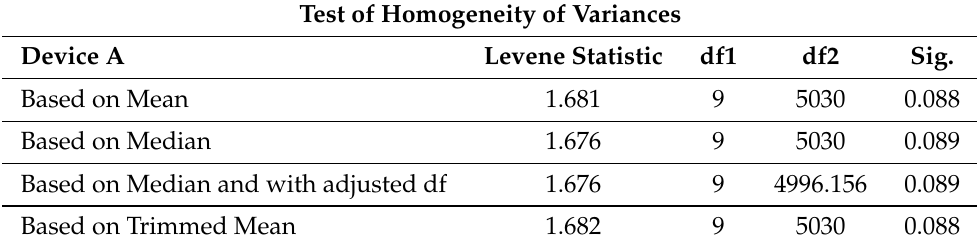
Table 2. ANOVA homogeneity of variance using levene test.